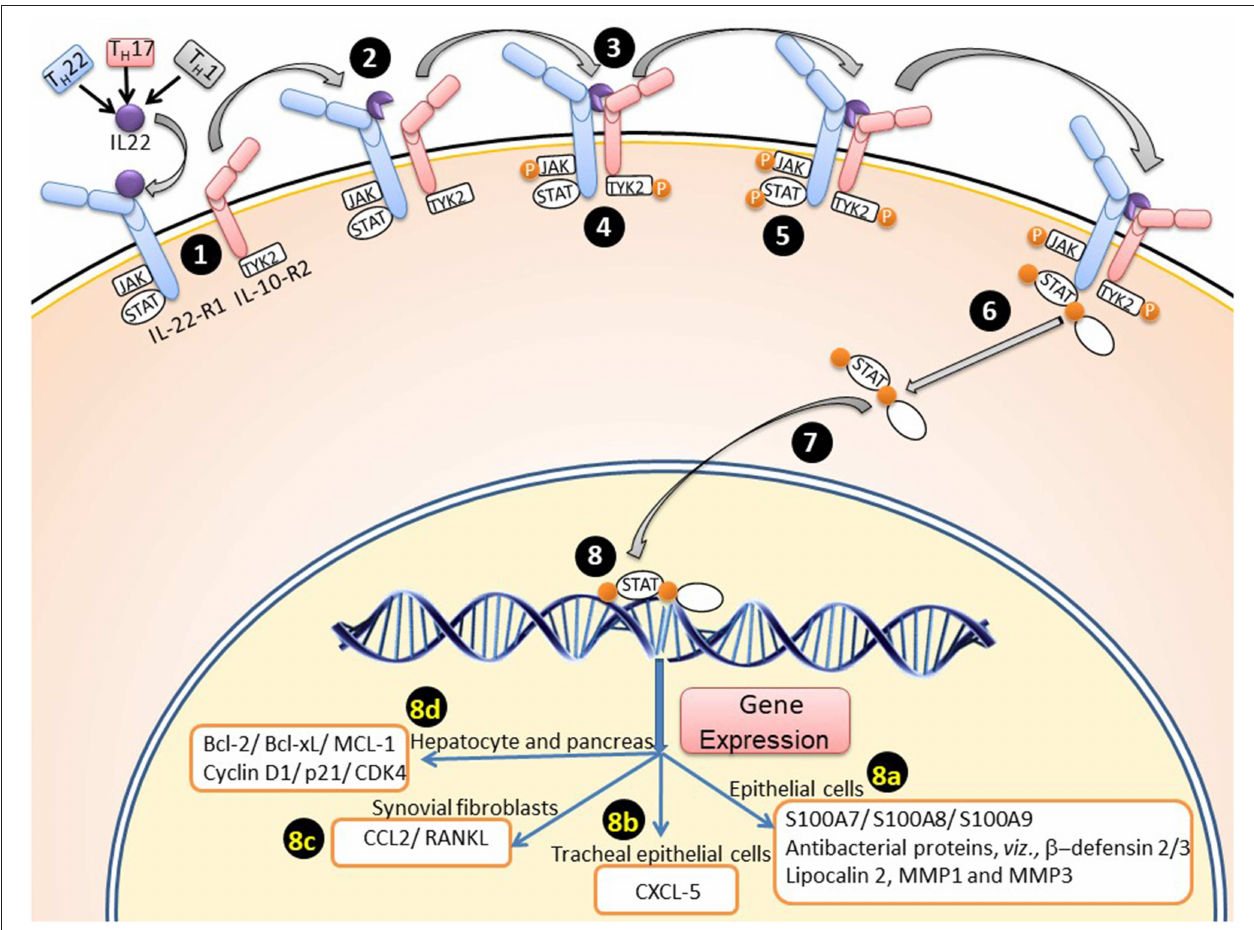
FIGURE 4 | IL-22 signaling pathway for expression of acute phase response proteins. 1. IL-22 receptor is a heterodimer of IL-22R1 and IL-10R2. Initially IL-22 binds to IL-22R1. 2. Upon binding, conformational change in IL-22 enhances its affinity toward IL-10R2. 3. leading to formation of heterodimeric receptor intracellularly, IL-22R1 is associated with JAK1 and STAT3 (STAT3 is recruited through tyrosine-independent recruitment) and IL-10R2 is associated with tyrosine kinase 2 (TYK2). 4. Binding of ligand with receptor initiates the phosphorylation of JAK1 and TYK2. 5. Receptor bound STAT3 is phosphorylated by JAK1. 6. Phosphorylation of STAT3 leads to dimerization of STAT3. 7. Dimerized STAT3 translocates to nucleus; in nucleus, it binds to response elements and regulate associated proteins. 8. STAT3 binds to different genes coding for acute phase proteins by different cells, viz. to viz. a). Epithelial cell ( β -defensin 2, β -defensin 3, lipocalin 2, MMP1 and MMP3, S100A7, S100A8, S100A9 b). tracheal epithelial cells (CXCL5); c). synovial fibroblast (CCL2/RANKL); d). hepatic and pancreatic cells (Bcl-2, Bcl-xL, MCL-1, Cyclin D1, p21,